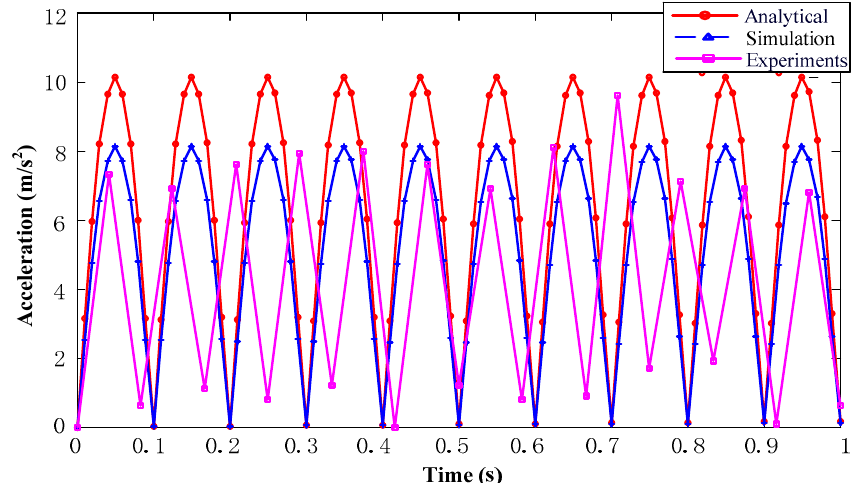
Figure 17. Comparison of theoretical analysis, simulation and test results of mass acceleration. Red lines represent the analytical calculation, and blue lines are the numerical results by ANSYS- MAXWELL2D. Pink lines are the experimental results.